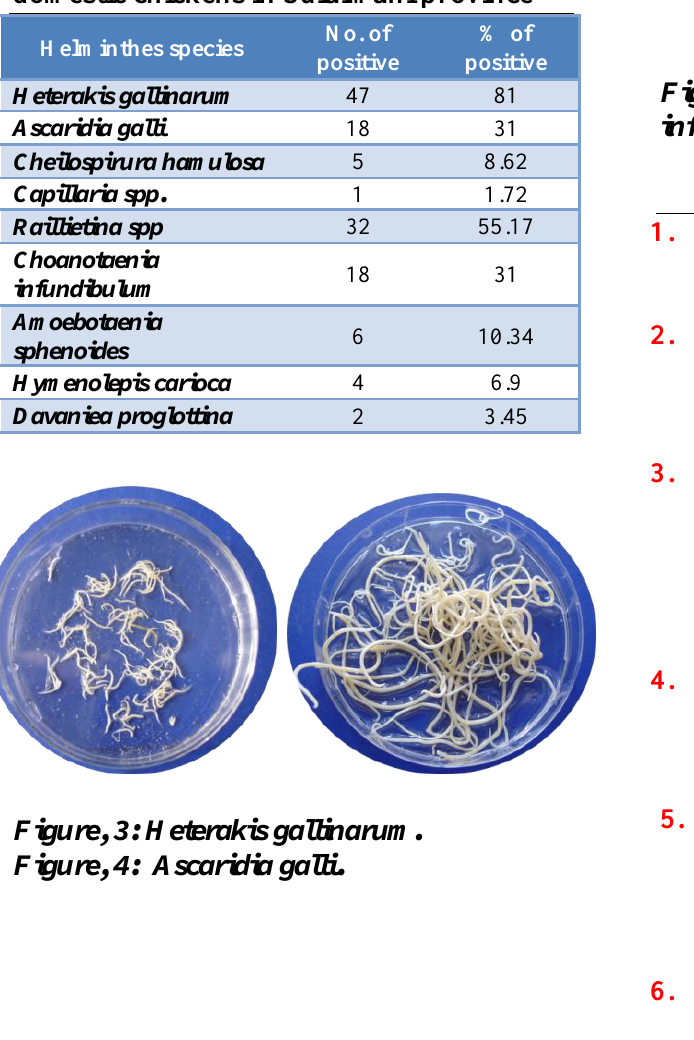
Table 4: Prevalence of endo-parasites in